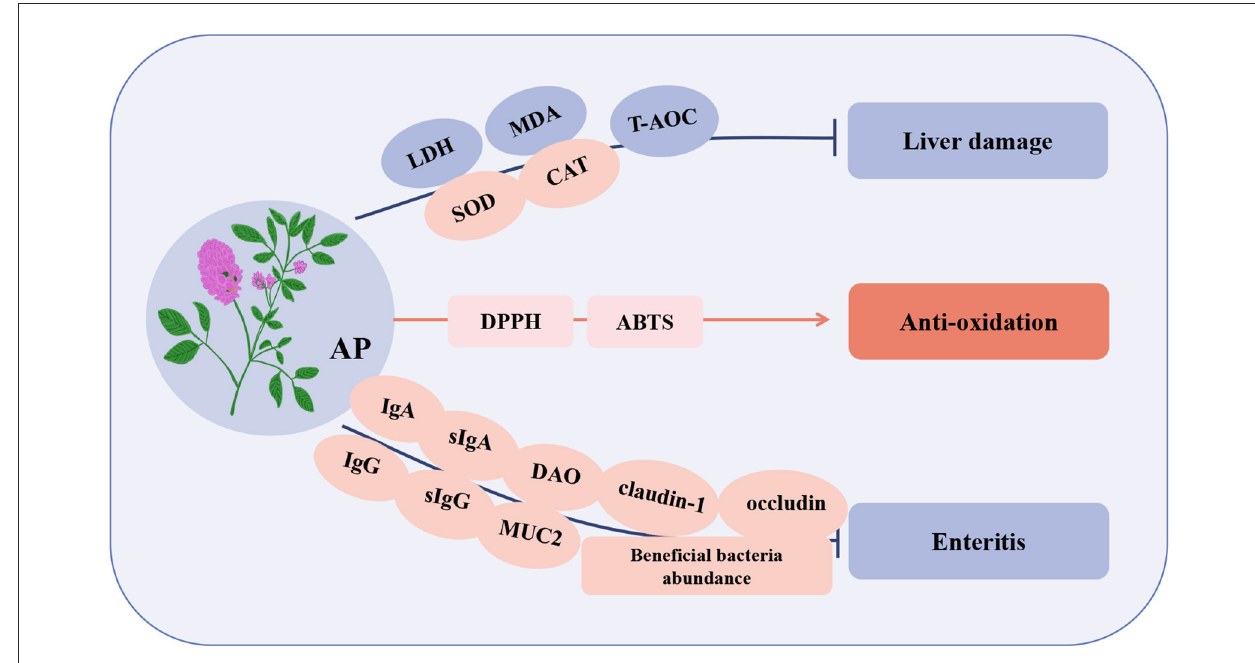
FIGURE4 Immunomodulatory effects of Alfalfa polysaccharide (AP) in poultry. LDH, lactate dehydrogenase; T-AOC, total antioxidant capacity; DPPH, 2,2-diphenyl-1-picrylhydrazyl; ABTS, 3-ethylbenzothiazoline-6-sulfonate; sIgG, secretory immunoglobulin G; DAO, diamine oxidase; MUC2, mucin